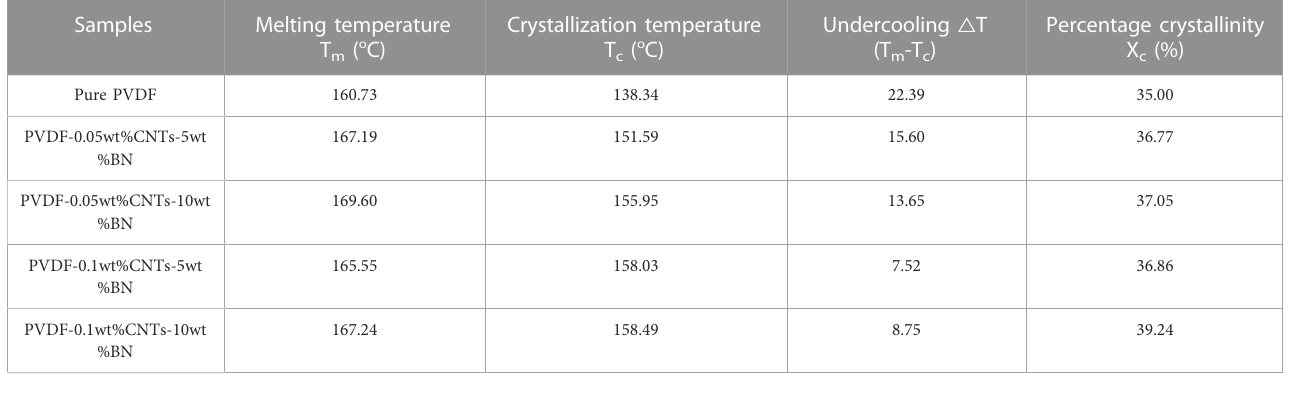
TABLE 2 DSC properties of the nanocomposites.